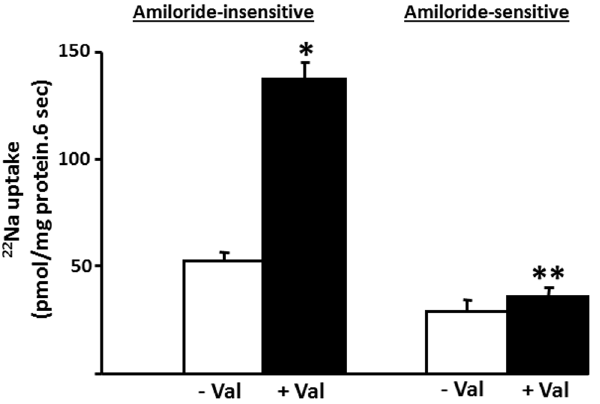
Figure 8. Effect of intravesicular membrane potential on Na- HCO 3 cotransport activities in basolateral membrane vesicles from proximal colon. Intravesicular positive membrane potential [generated using inward K + gradient and valinomycin (Val)] dependent HCO 3 -gradient-driven 22 Na (0.1 mM) uptake was measured as described in the Method section both in presence and absence of 1 mM amiloride. Intravesicular positive potential stimulated amiloride- insensitive HCO 3 gradient-driven 22 Na uptake. Intravesicular positive potential did not affect amiloride-sensitive Na-HCO 3 cotransport. Uptake obtained in presence of amiloride represented amiloride- insensitive uptake, while amiloride-sensitive uptake was calculated by subtracting the amiloride-insensitive uptake from that of uptake in the absence of amiloride. * p , 0.001 compared to –Val in amiloride- insensitive; ** p , 0.05 compared to –Val in amiloride-sensitive. doi:10.1371/journal.pone.0062864.g008 HCO 3 was performed in crypt glands isolated from distal colon, which is devoid of NBCe expression (Figures 2A and 3) and amiloride-insensitive NBC activity [7]. As shown in Figure 12, HOE694, which inhibits NHE1-mediated H + -extrusion, only partially but significantly acidified the pHi in crypt cells (dpHi/